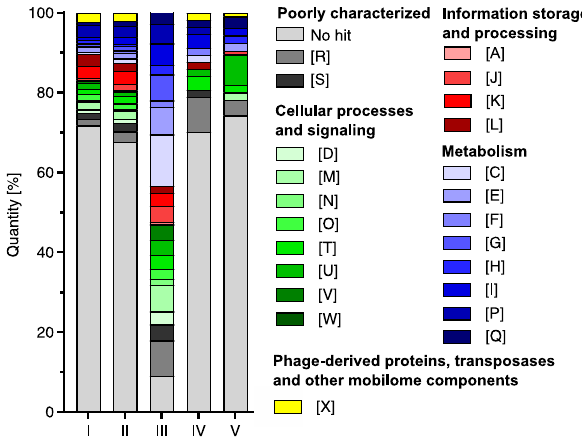
Figure 4. ORFs of areas I to V (groups of genes, which are singletons to KRP1 or shared by KRP1 and up to five other P. aeruginosa strains; see Fig. 3) classified by Clusters of Orthologous Groups (COGs) database.